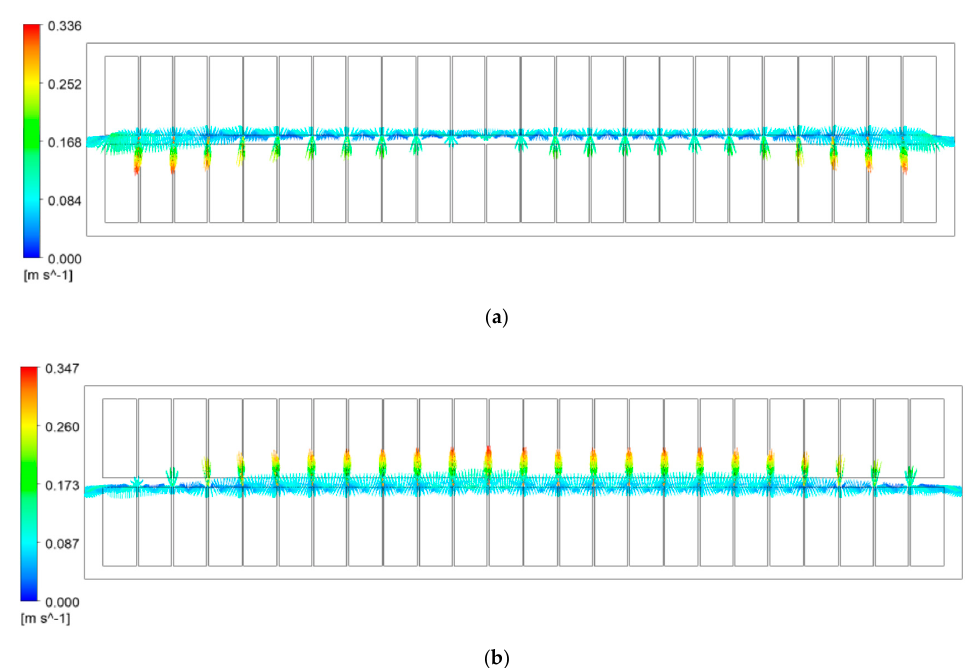
Figure4. Bathflowintheverticalplaneintheunslottedcase0: ( a )Y =+ 70mmand( b )Y = − Figure 4. Bath flow in the vertical plane in the unslotted case 0: ( a ) Y = +70 mm and ( b ) Y = − 70 mm plane.